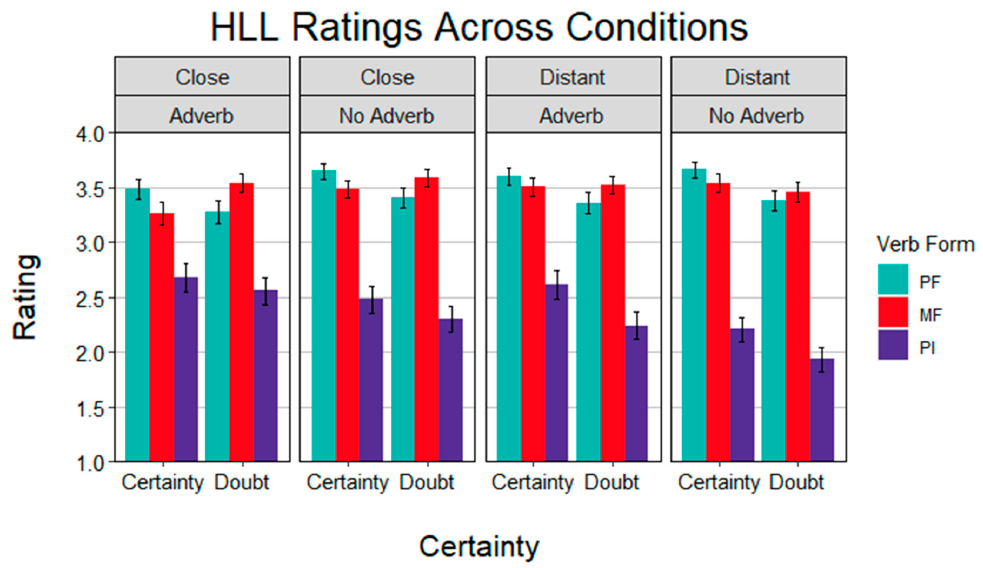
Figure 1. Average HLL sentence ratings with 95% confidence interval bars.